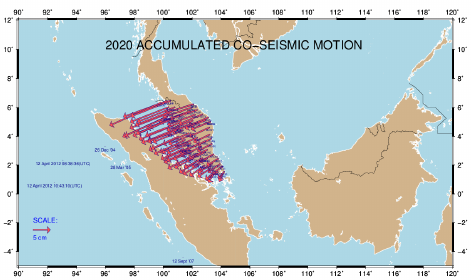
Fig. 12. Accumulated horizontal co-seismic motions of the Penin- sular Malaysia CORS stations at epoch 2020.0 due to the 2004 Mw 9.2 Sumatra-Andaman, 2005 Mw 8.6 Nias-Simeulue, 2007 Mw 7.9 Bengkulu, 2010 Mw 7.8 Mentawai and 2012 Mw 8.6 & 8.2 Indian Ocean